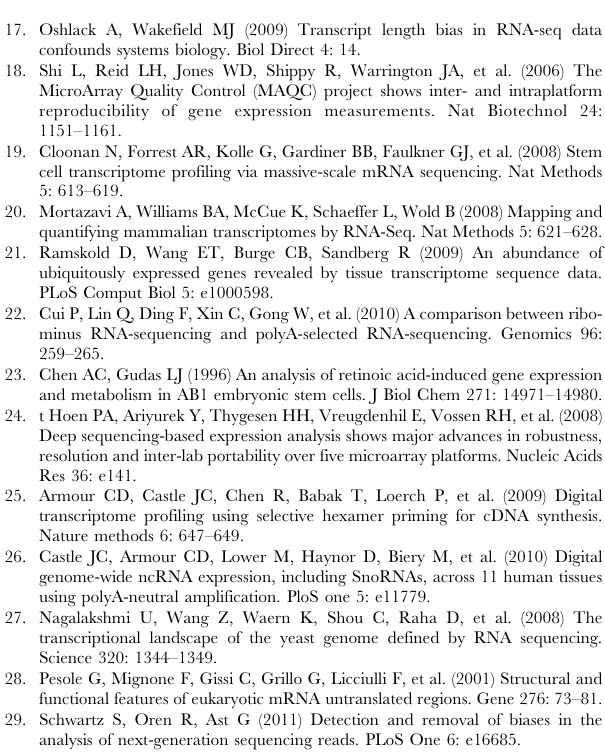
Table S1 Ribosome depletion, tag types and